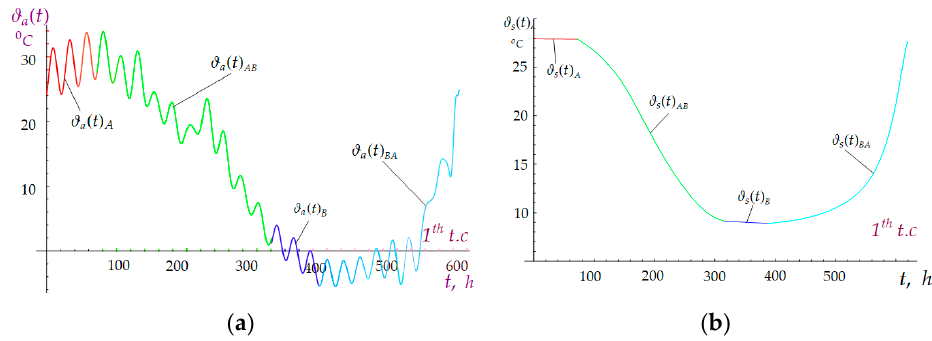
( a ) ( b ) Figure 6. ( a ) Air ( ) t ϑ and ( b ) sea temperature ( ) t ϑ through one transport cycle. Figure 6. ( a ) Air ϑ a ( t ) and ( b ) sea temperature ϑ sd ( t ) through one transport cycle. a sd . m eg and ϑ eg ( t ) at the WHRSG inlet, with During navigation, the fluctuation